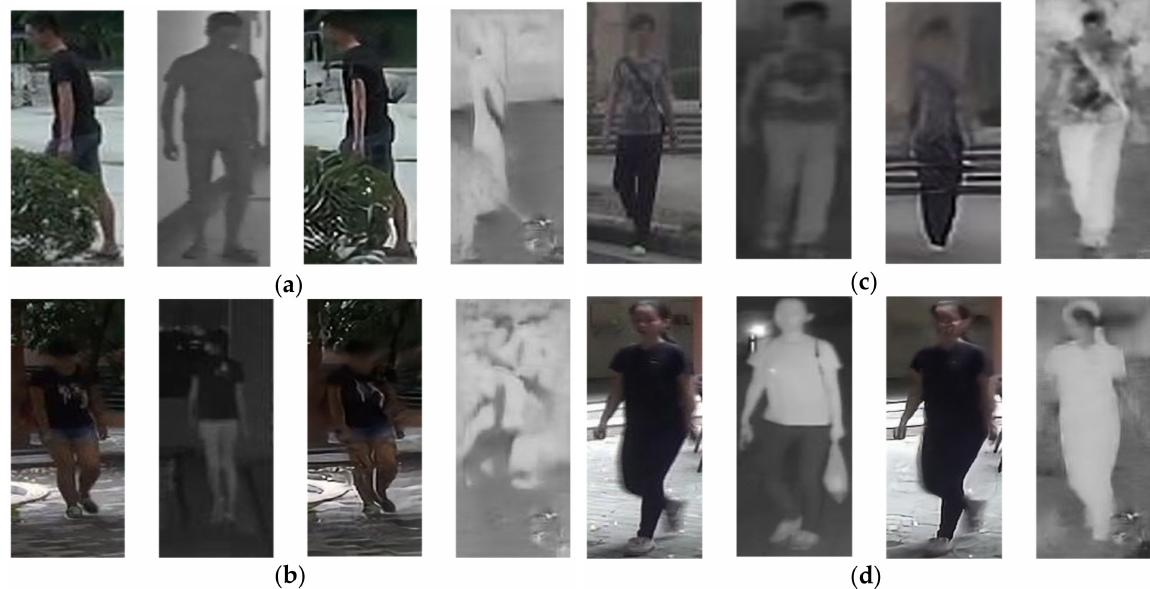
Figure 20. Cases of Type I error, Type II error, correct recognition cases. ( a ) Cases of Type I error, ( b ) cases of Type II error, ( c ) correct recognition cases (male), ( d ) correct recognition cases (female). In ( a – d ), from left to right are original visible-light image, original IR image, reconstructed visible-light image, and syn-IR image.